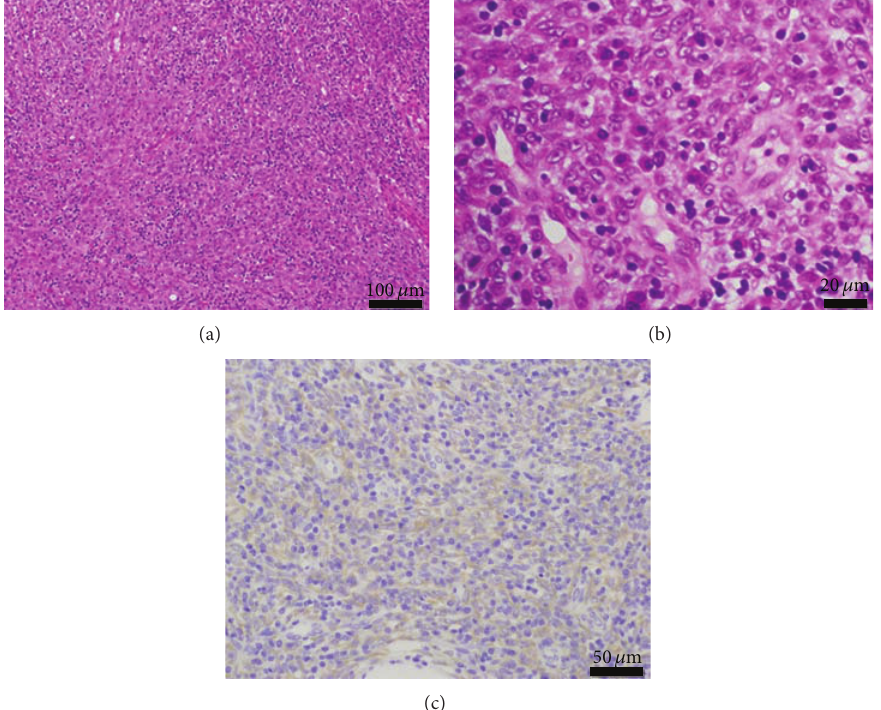
Figure 4: Photomicrograph of the tumor specimen showing spindle cells with infiltration of lymphocytes, plasma cells, and foamy histiocytes ((a), (b): hematoxylin and eosin staining). Immunohistochemical staining showing diffuse cytoplasmic reactivity for ALK (c).